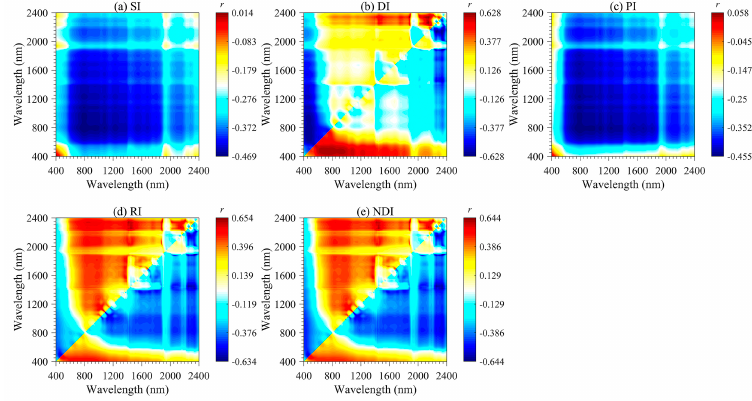
Figure 5. Two-dimensional image maps of correlations ( r ) between SOM and five 2DI (SI, DI, PI, RI, and NDI) forms calculated based on the calibration set ( n = 112).